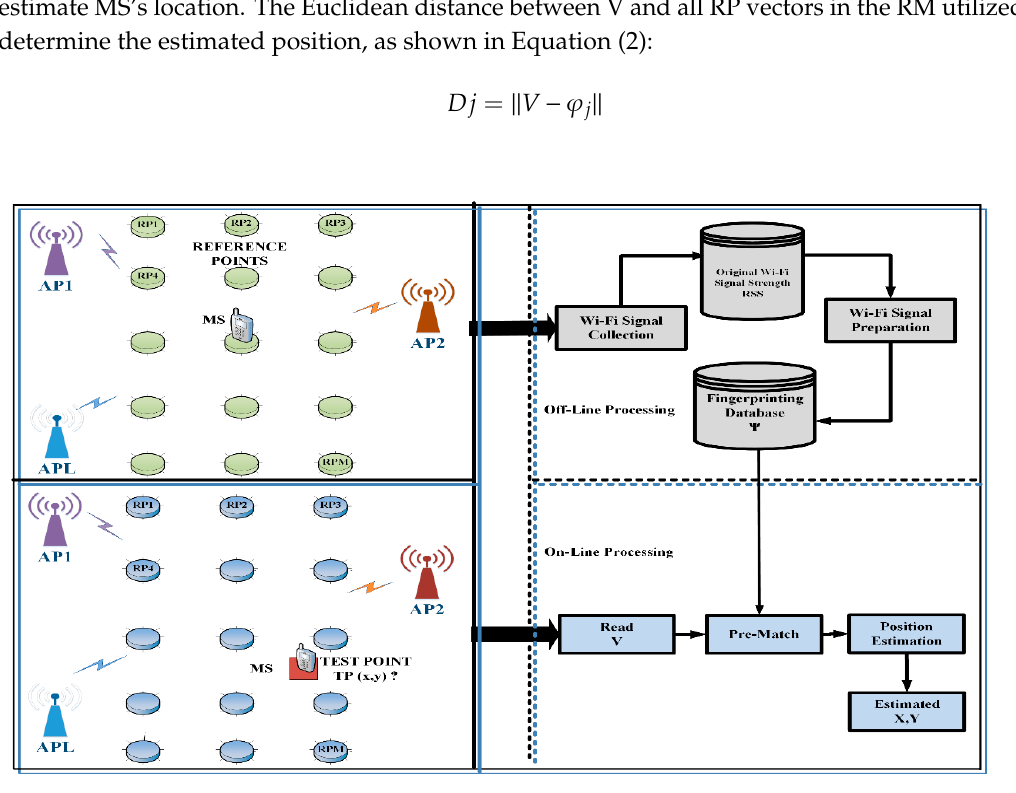
Figure 1. The fingerprinting-based method.